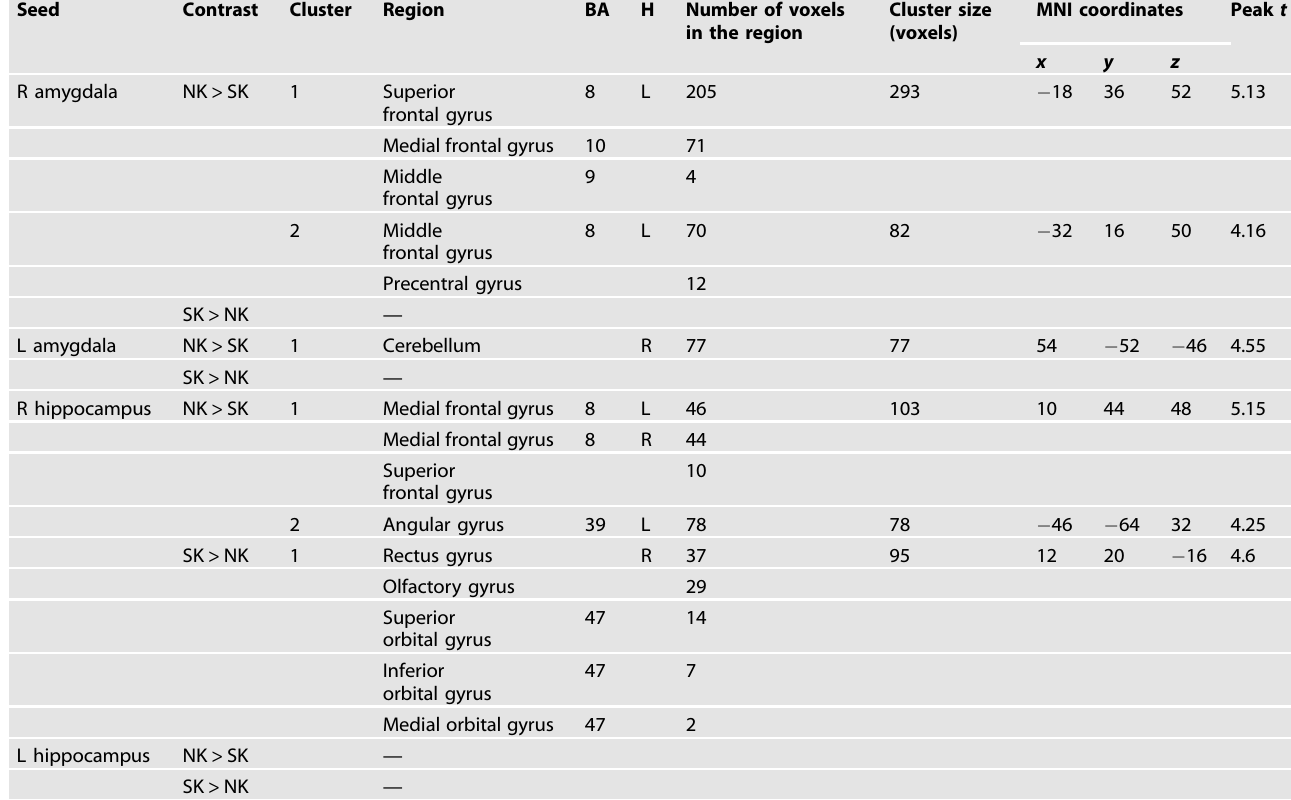
Table 2. Functional connectivity between subcortical and prefrontal regions using the amygdala and hippocampus seeds during emotion suppression (vs. looking at the negative pictures).